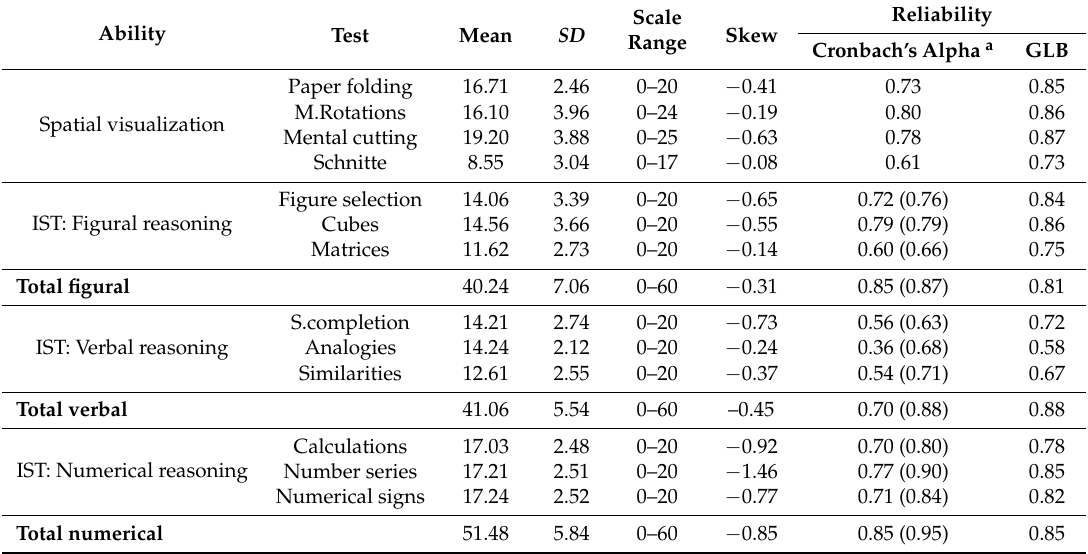
Table 2. Means, standard deviations and reliability estimates of all measures included in the